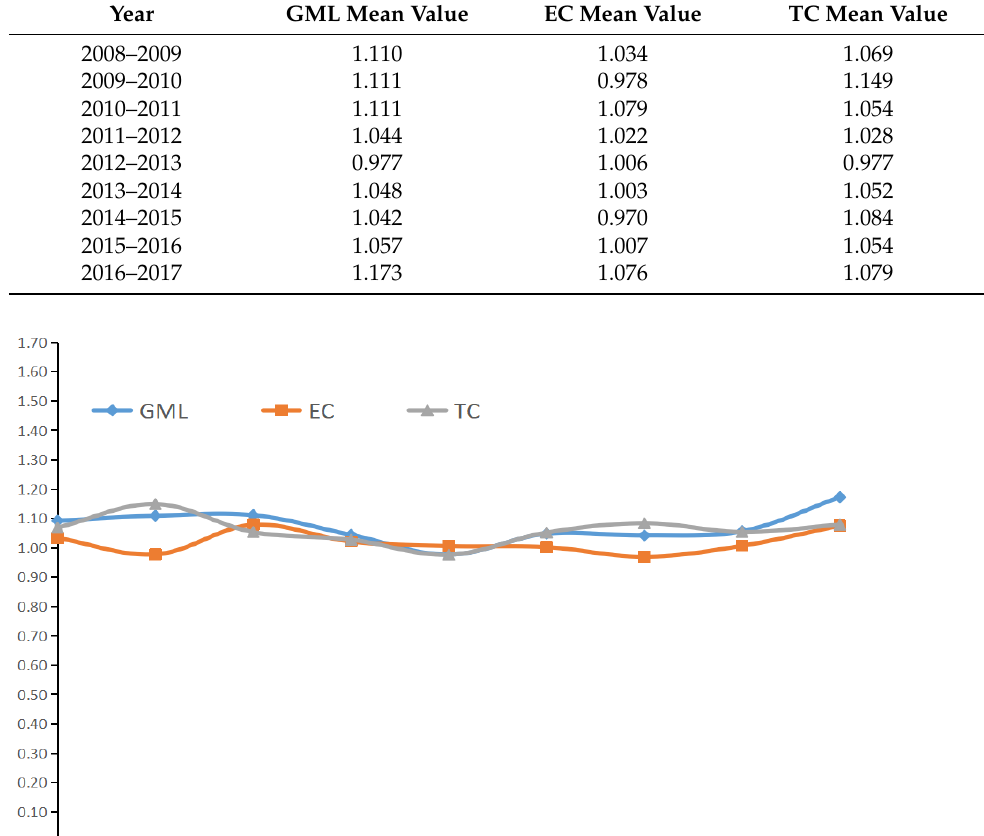
Table 4. Average GML index and its decomposition by year in China.